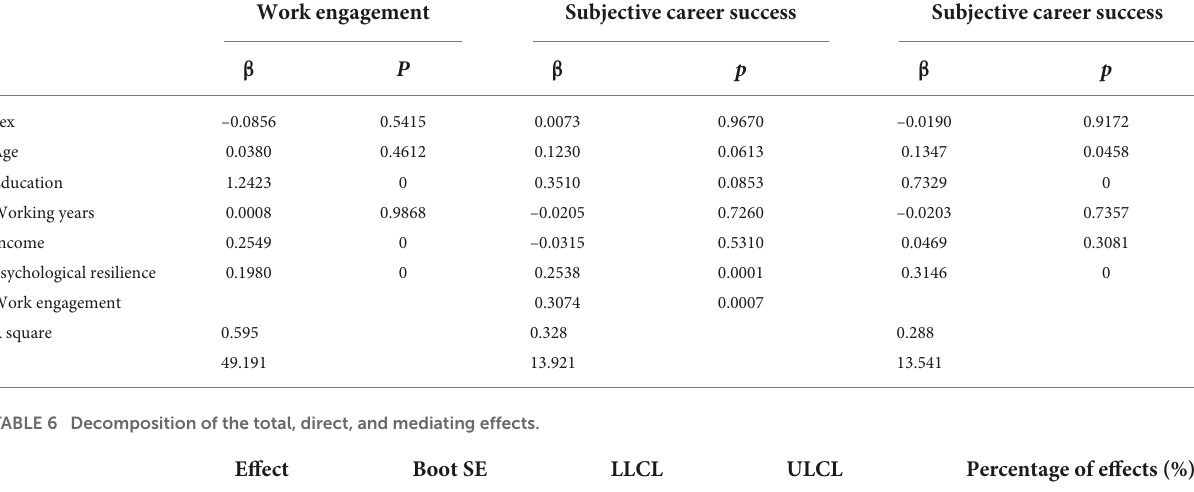
TABLE 5 Mediation test of work engagement.